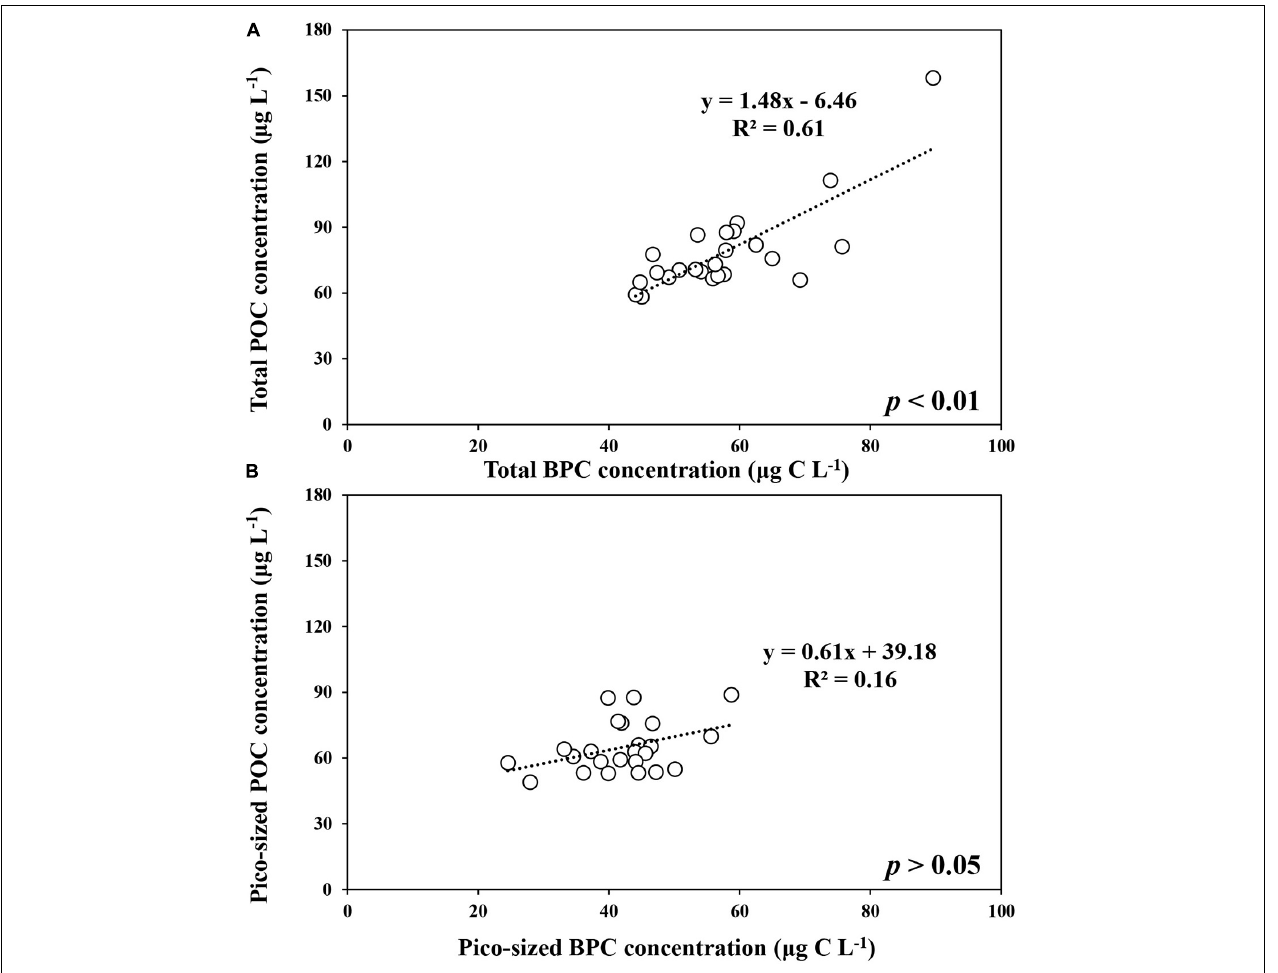
FIGURE 4 | The relationship between POC and BPC concentrations of total ( > 0.7 µ m) (A) and pico-sized (0.7–2 µ m) (B) POM at JBS during the ice-covered period,